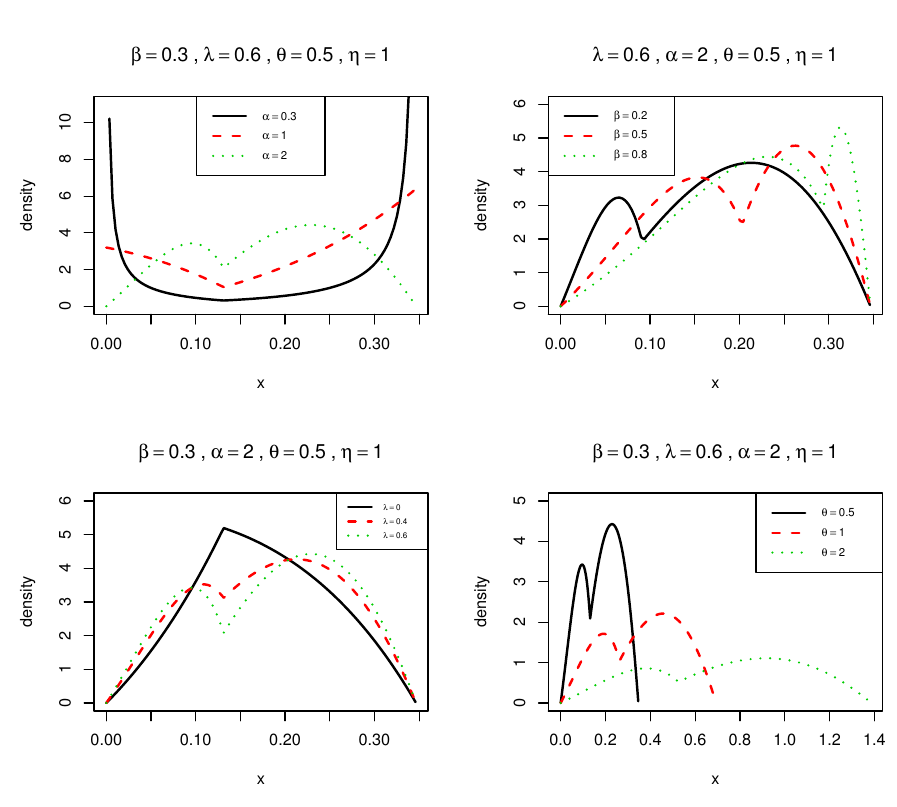
Figure 1 – The graphs of the densities of the GOTTS-E distribution with 0 ≤ λ ≤